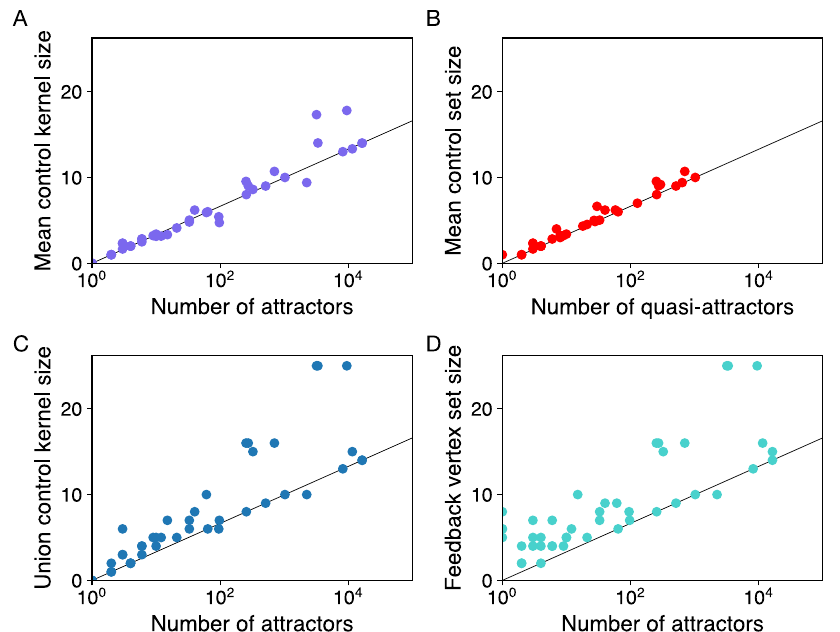
Fig. 2 Comparing our control kernel results with those obtained using two alternative methods for computing controlling nodes. A For comparison, we replot mean control kernel size versus number of attractors, as in Fig. 1A. B Mean control set sizes computed for 36 networks using the stable motif algorithm, which groups some cyclic attractors into quasi-attractors. Logarithmic scaling of the control set sizes with respect to the number of quasi- attractors is clearly visible. C For comparison to the feedback vertex set, which places an upper bound on the minimal control set required to reach all attractors, we compute the size of the union of control kernel nodes of each network across all its attractors. D The size of feedback vertex sets is comparable to union control kernel sizes in C